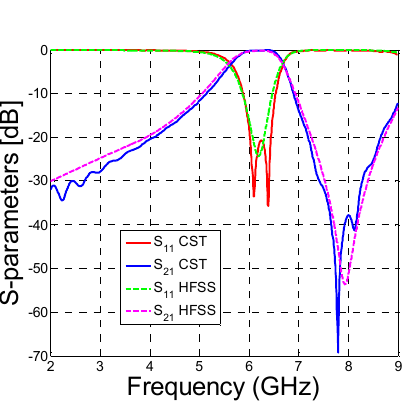
FIGURE 10. HMSIW with C-HMC tunable band-pass filter simulated results.